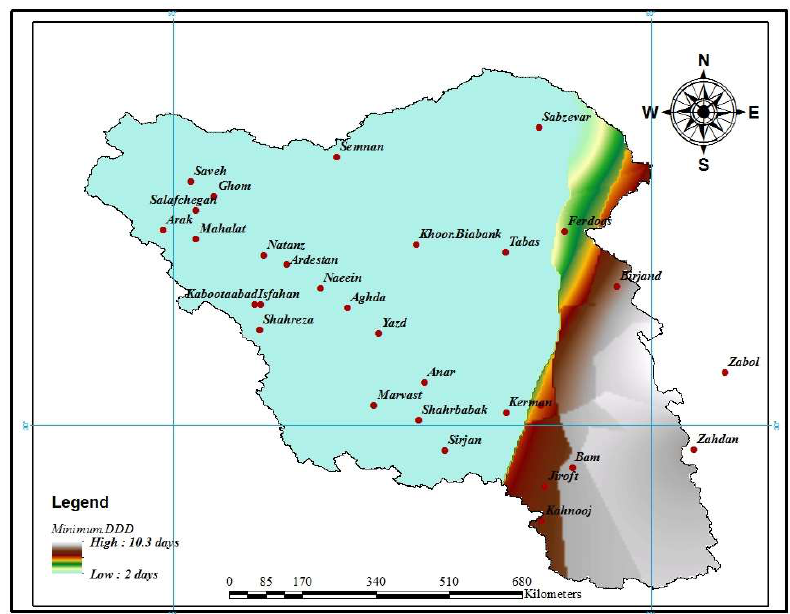
Figure 11. Minimum annual-maximum dust day duration in the study area.